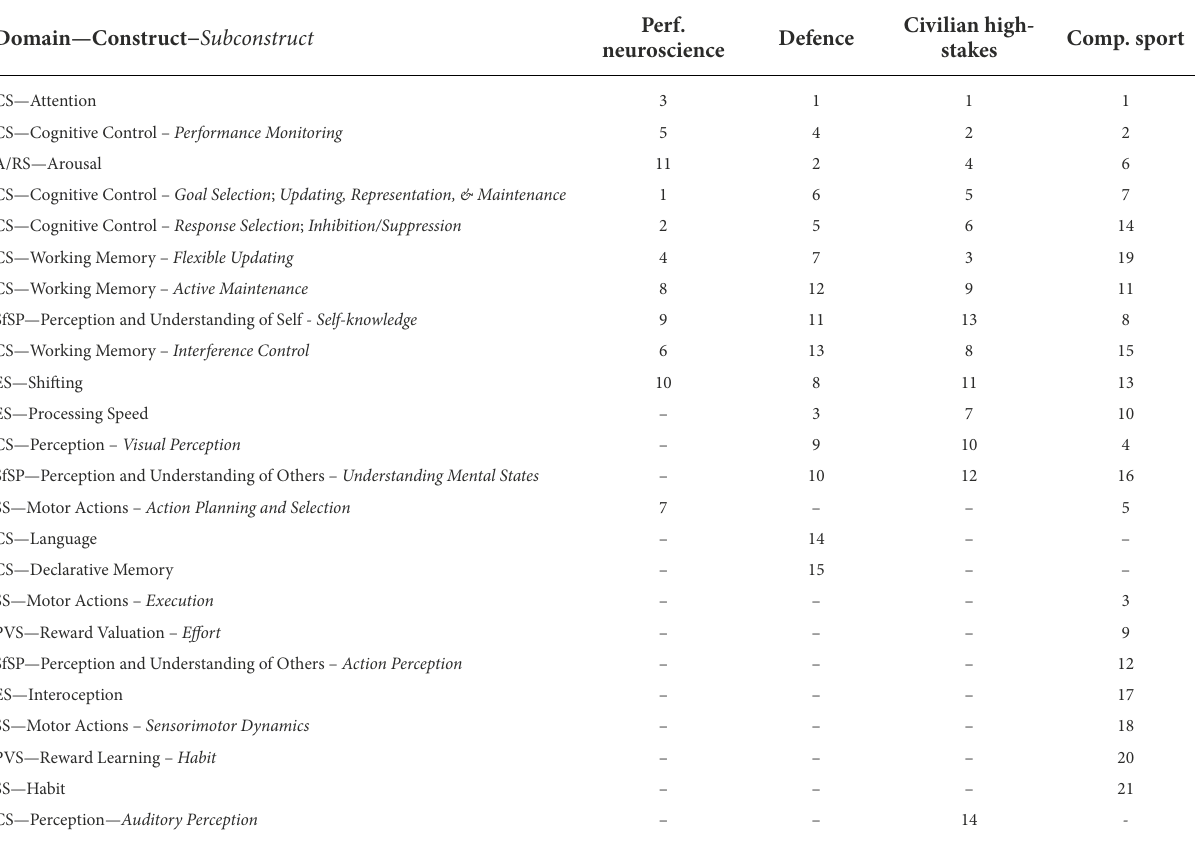
TABLE 4 Construct rankings across panels.